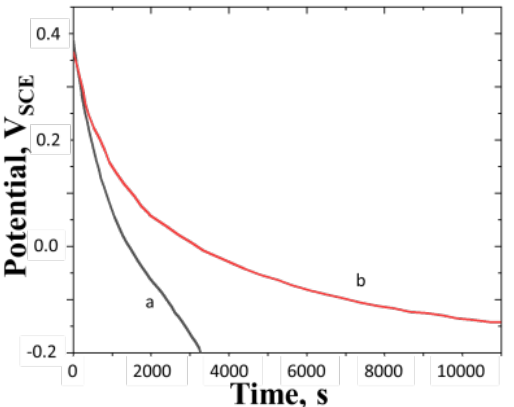
Figure 4. Chronopotentiograms for reduction of polyaniline films. ( a ) Black line: from equilibrium potential to − 0.2 V at current density of − 2.25 A m − 2 ; surface mass density of the film = 24.4 g m − 2 ; ( b ) Red line: constant current of − 8.75 × 10 − 4 A m − 2 ; surface mass density of the film = 13.91 g m − 2 . Concentration of H 2 SO 4 = 0.5 M, temperature = 25 ◦ C. All potentials are reported with respect to SCE. Figure 4a has a point of inflection at around 1500 s, where the shape of the chronopoten- tiogram changes from concave to convex. The change in the curvature of the potentiogram